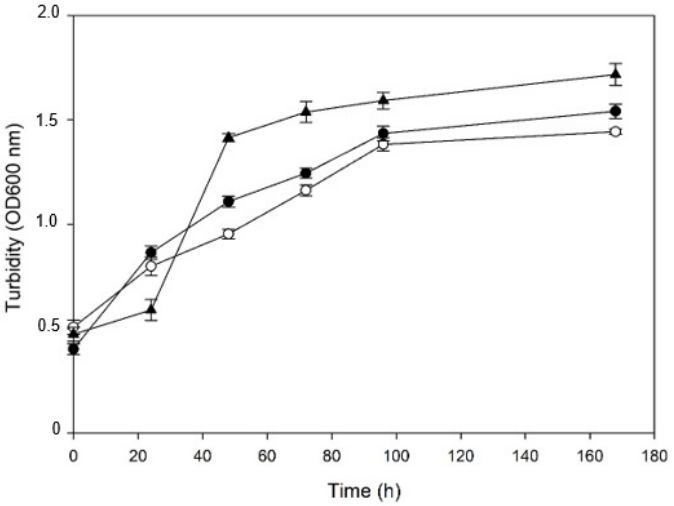
Figure 4. Growth curves were obtained from cultures of the bacterial consortium in different